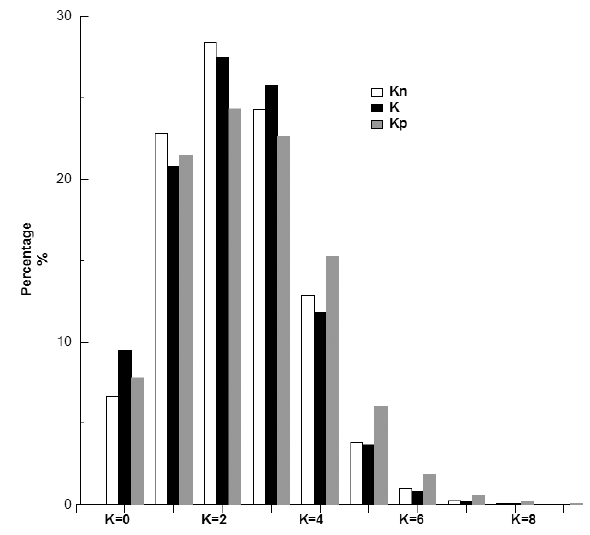
Figure 7. Comparison between the frequency distribution of the longitudinal interpolation results (dark grey bar), the latitudinal in- terpolation results (light grey bar), Kn calculated with the neural network (white bar) and the K-real at LIV (black